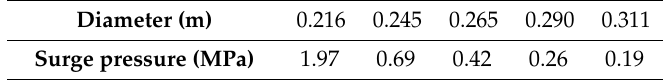
Table 6. Surge pressure at the bottom hole as the pipes trip in under different wellbore diameters. Diameter (m)